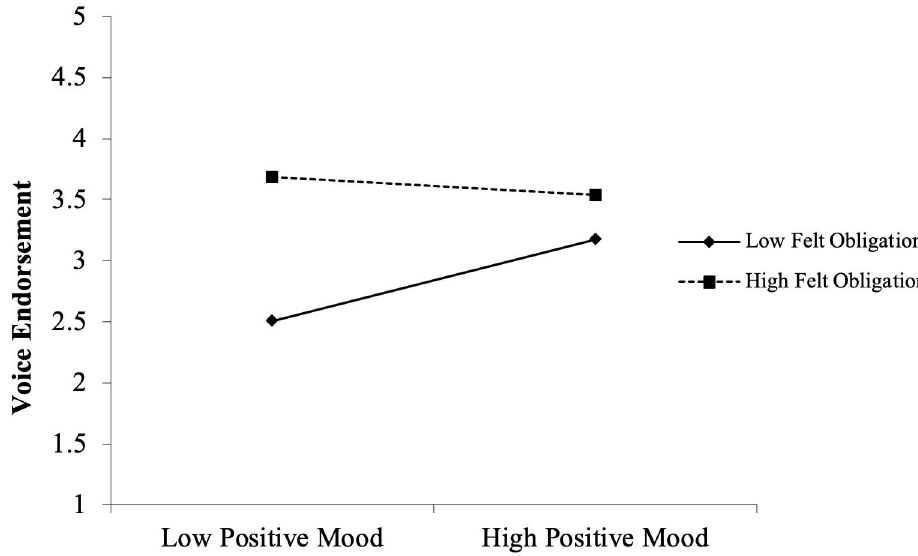
Fig 3. Interactive effect of positive mood and felt obligation on voice